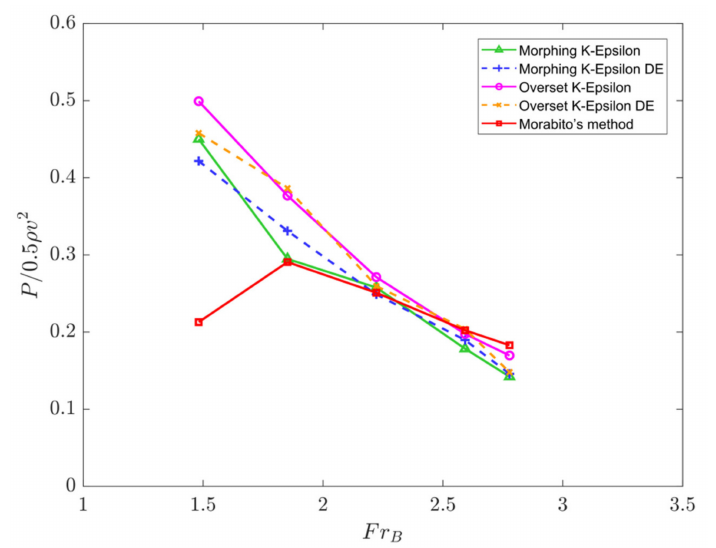
Figure 12. Maximum pressure found using overset and morphing mesh techniques. The values calculated by using Morabito’s equation are also